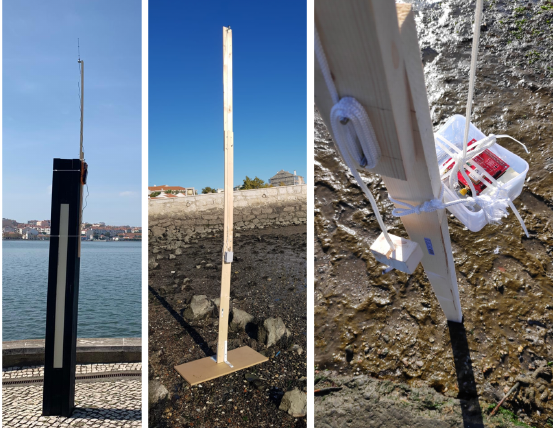
Figure 6. Gateway and sensor nodes in the monitoring